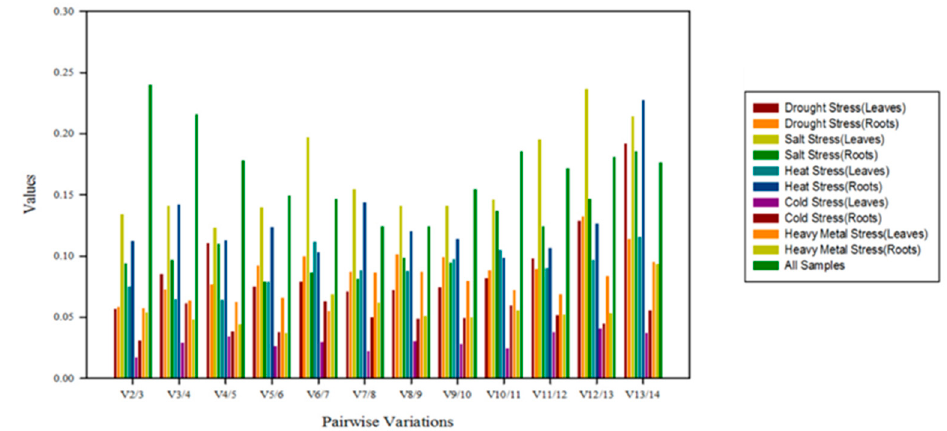
Figure 5. Pairwise variation (V) measure of the candidate reference genes.